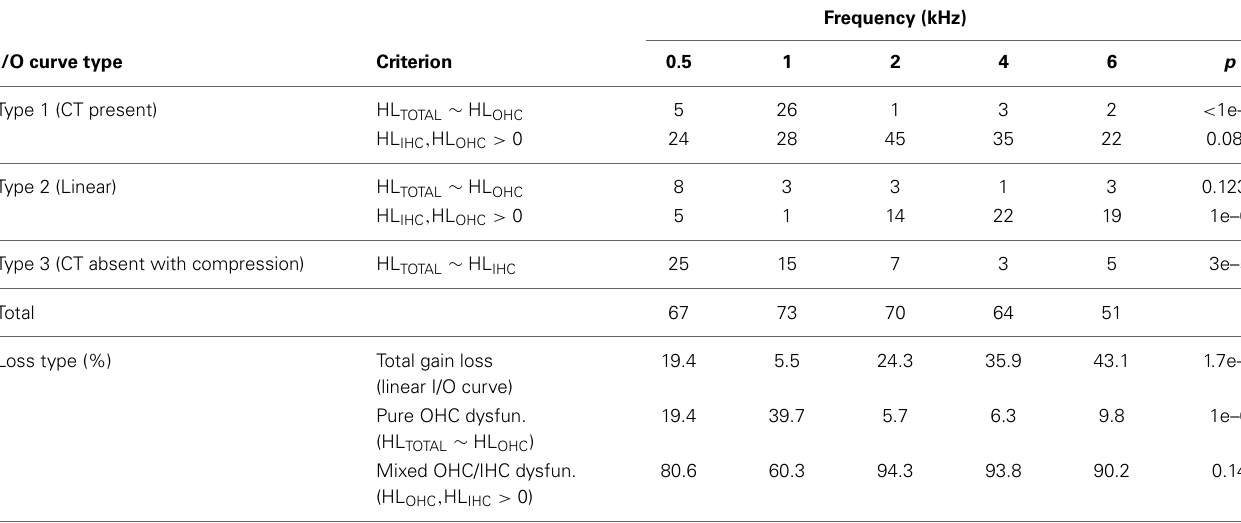
Table 3 | Number of cases per I/O curve type and frequency (top) and percentage of cases per loss type